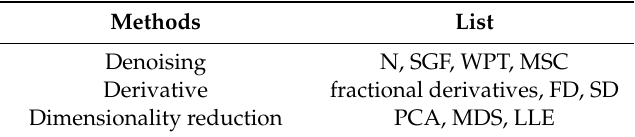
Table 2. List of Preprocessing